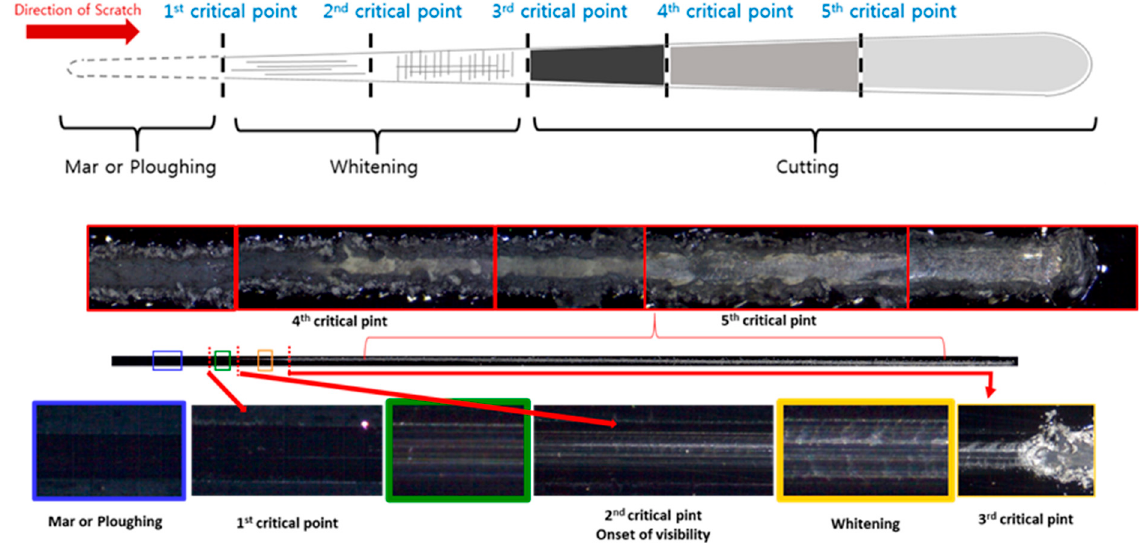
Figure 3. Scratch mechanism evolution of automotive multilayer coating [8].